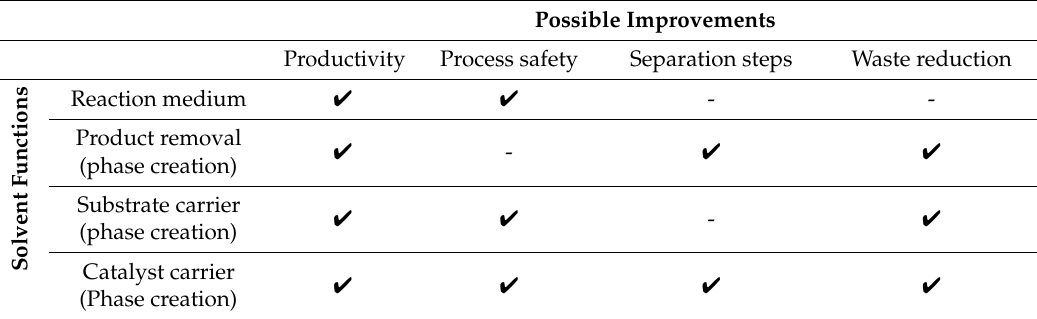
Table 8. Solvent functions in reaction and their possible